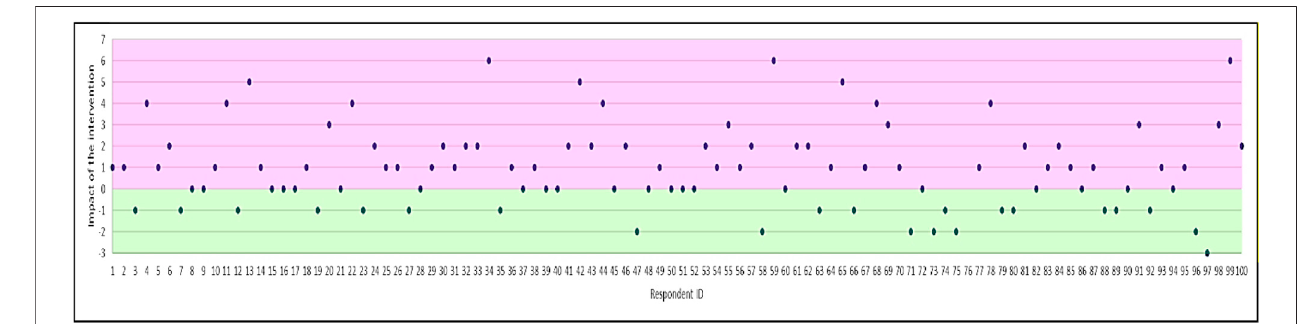
FIGURE 3 | Magnitude of change in perceptions (difference in total score for the perceptions subscale). Positive effect of the intervention is shown in purple (i.e. increase in accuracy of perceptions of antibiotics and AMR).